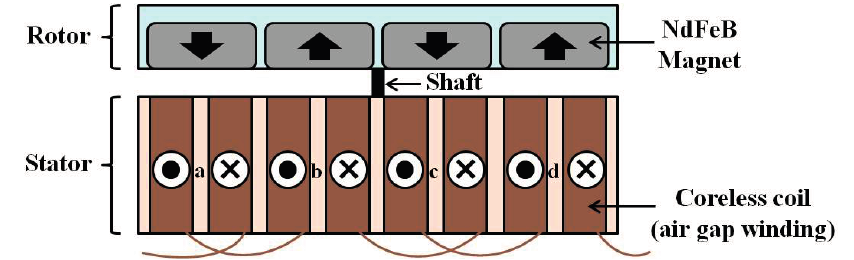
Figure 3. Electromagnetic coupling structure of the proposed APMM.